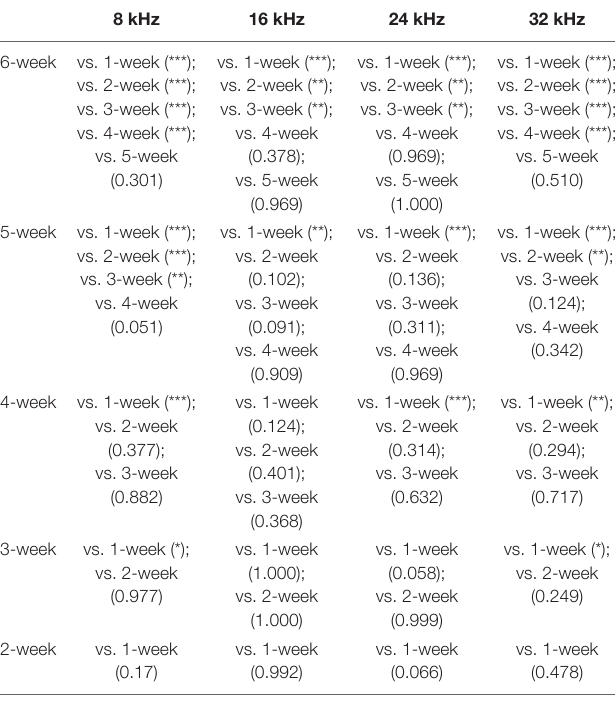
TABLE 2 | Statistical analysis of weekly auditory brainstem response (ABR) threshold shifts of the 5-aza